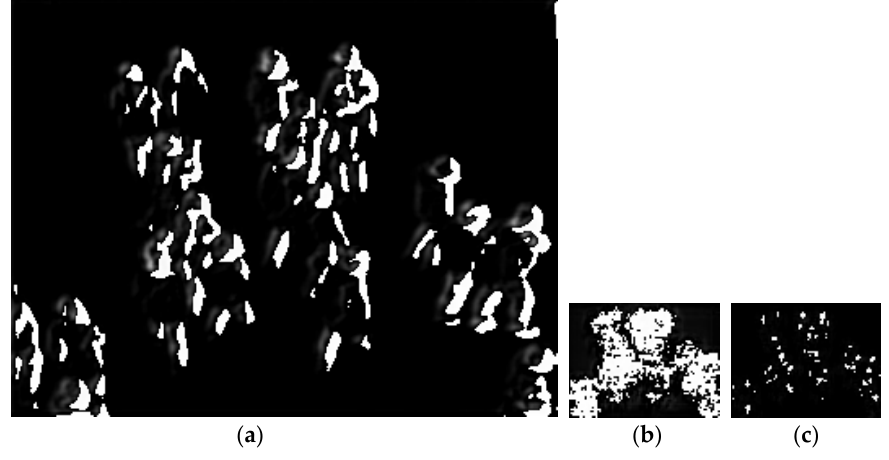
Figure 4. Representative feature maps in the MC-CNN. ( a ) Shared CNN; ( b ) crowd-count classification stage; ( c ) first stage of crowd-density estimate.